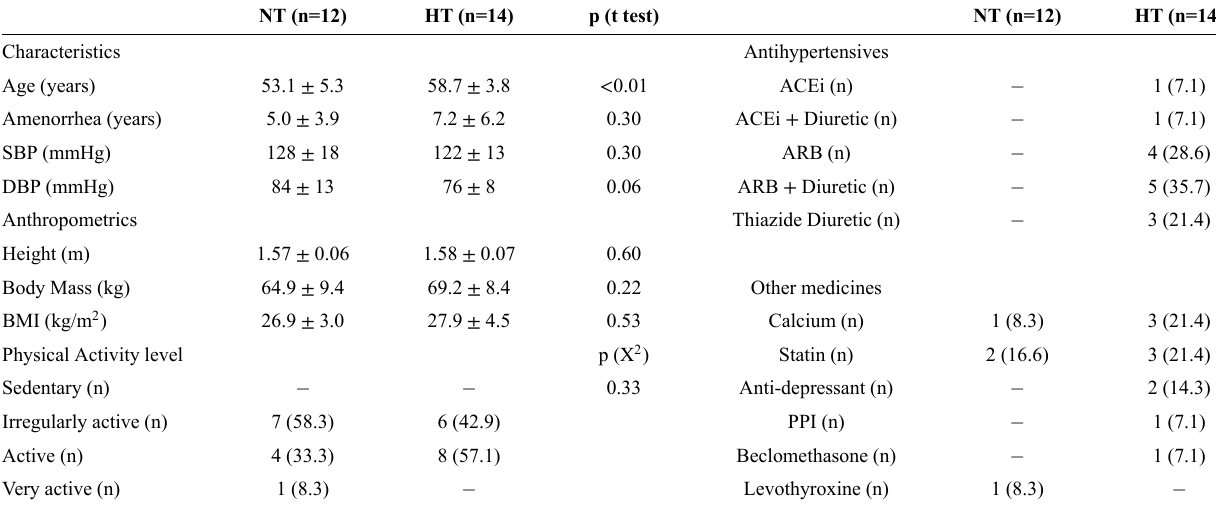
Table 1 - Anthropometric, activity level, and medical characteristics of normotensive and hypertensive groups. Data are presented in Mean ± Standard Deviation or frequency (% within the group). NT